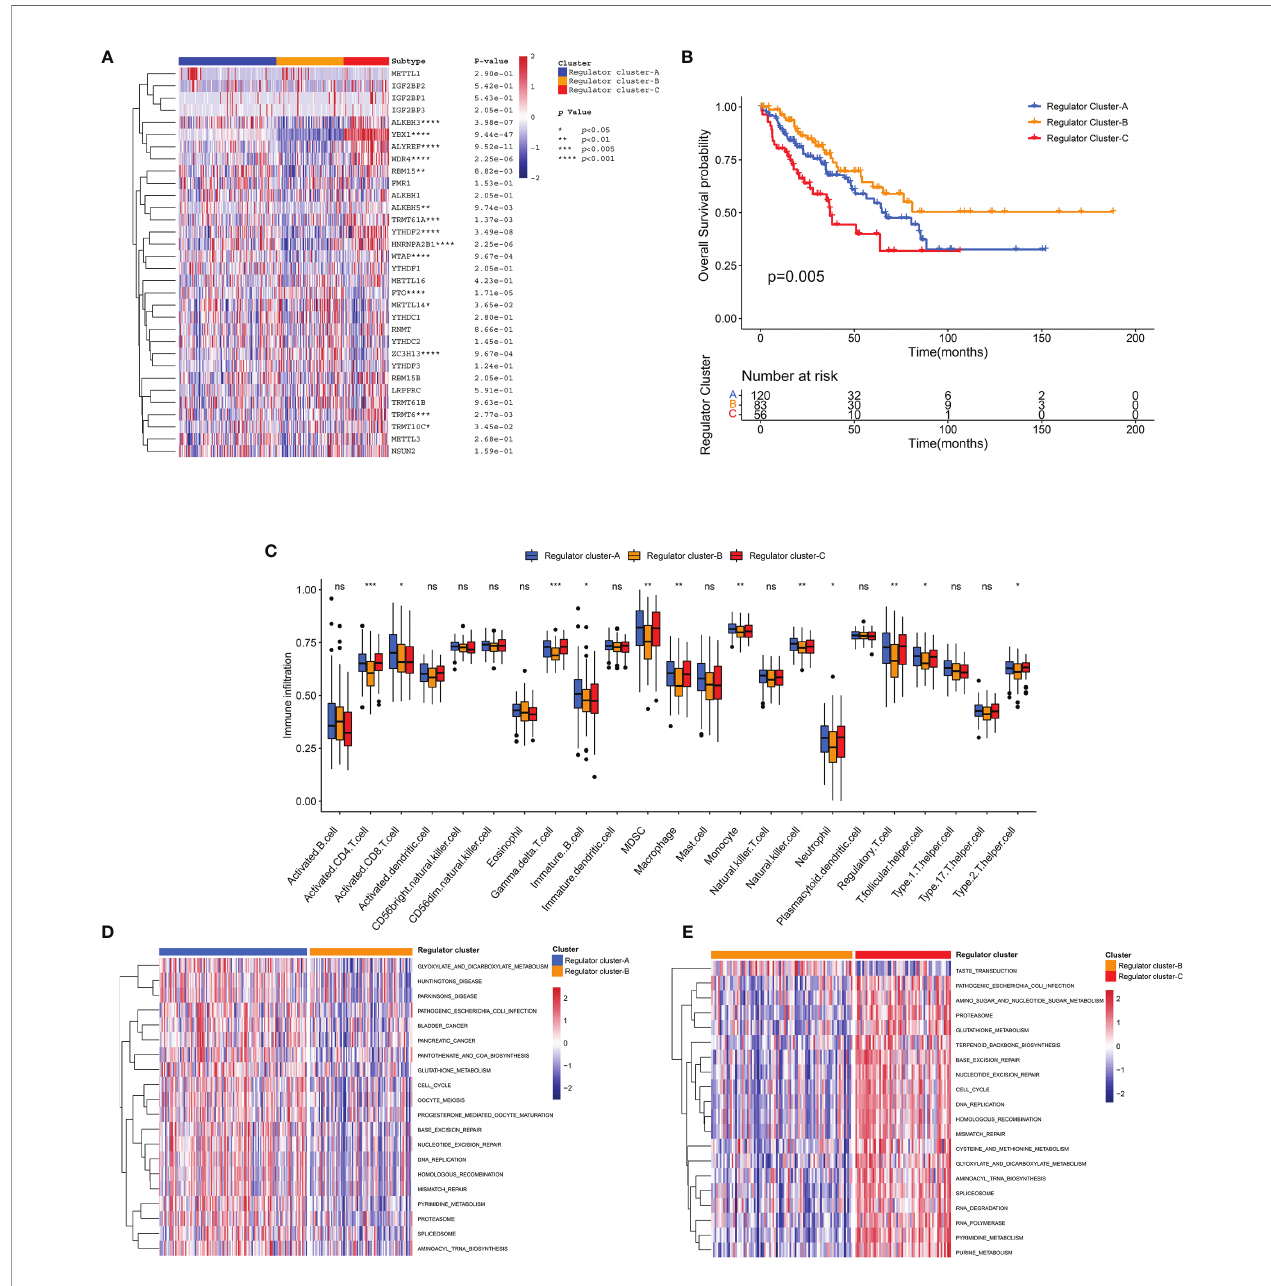
FIGURE 4 | Identi fi cation of regulator clusters and related biological characteristics. (A) Heatmap of 32 RNA modi fi cation regulators among distinct regulator clusters. (B) The OS curve comparing survival of the TCGA-SARC cohort in Regulator Clusters A (blue), Regulator Clusters B (orange), and Regulator Clusters C (red). (C) The in fi ltration of immune cells within distinct regulator clusters. The box plot extends from the 25th to 75th percentile, and the central parallel line indicates the median. (D, E) The GSVA illustrating pathway enrichment among distinct regulator clusters. ns, p ≥ 0.05; *, 0.01 ≤ p < 0.05; **, 0.001 ≤ p < 0.01; ***, 0.0001 ≤ p <